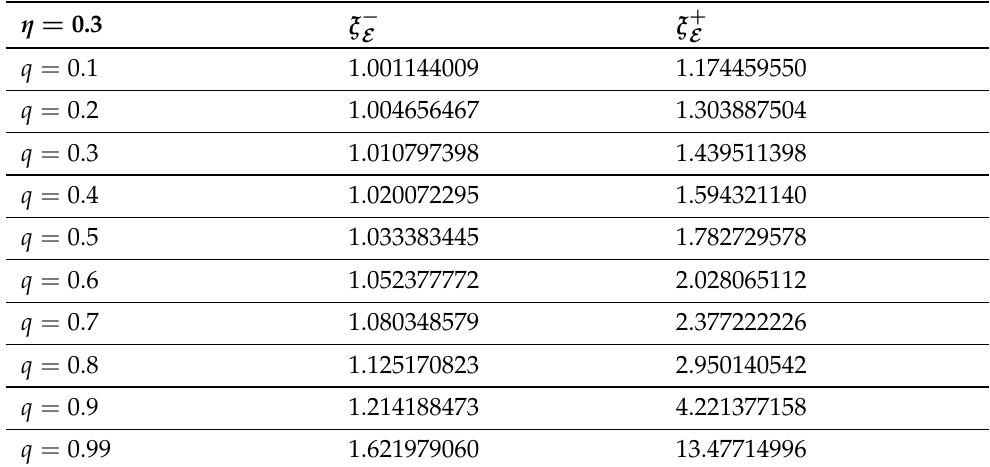
≤ q ≤ 0.99 and 0.4 ≤ η ≤